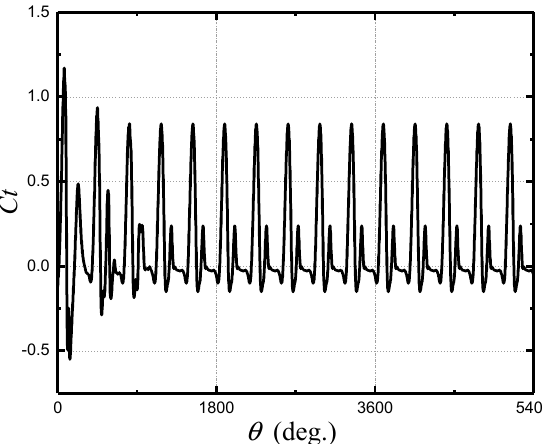
Figure 9. Convergence criterion: the tangential force coefficient with azimuth.